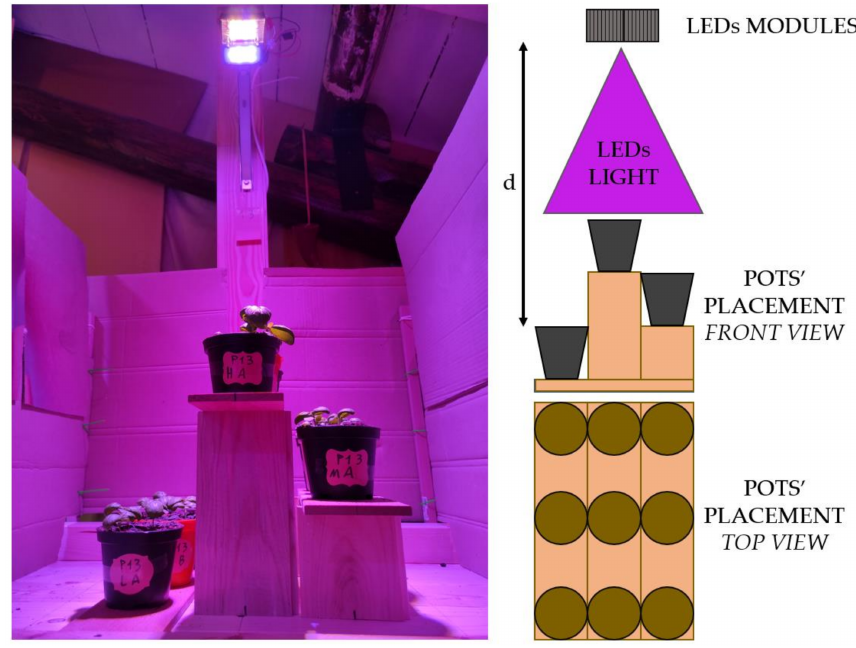
Figure 2. Experimental setup.